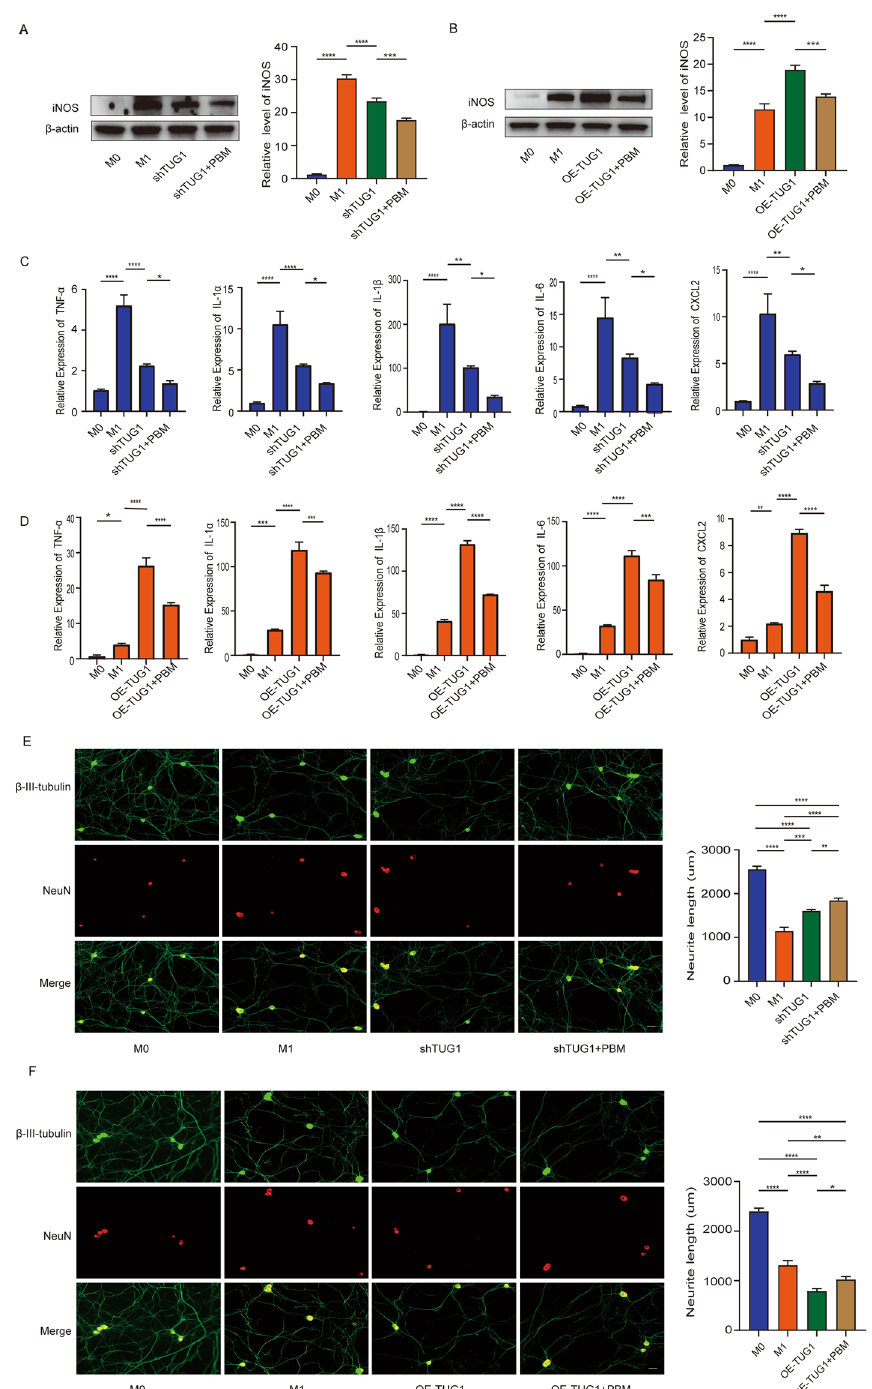
Fig. 3 Knockdown of lncRNA TUG1 inhibits macrophage polarization and inflammation and promotes neuronal axon growth. A After transfection with TUG1 knockdown adenovirus, the protein expression of iNOS was detected by western blotting assay. B After transfection with TUG1 overexpression adenovirus, the protein expression of iNOS was detected by western blotting assay. C After knockdown of TUG1, RT-PCR detected the expression of TNF-α, IL-1α, IL-1β, IL-6, and CXCL2. D After overexpression of TUG1, RT-PCR detected the expression of TNF-α, IL-1α, IL-1β, IL-6, and CXCL2. E , F Immunofluorescence was used to observe the effect of MCM on axonal growth of DRG. Green indicates β-III-tubulin; red indicates NeuN. Scale bar, 50 μm. n 3 per group. * P < 0.05, ** P < 0.01, *** P < 0.001, **** P < =